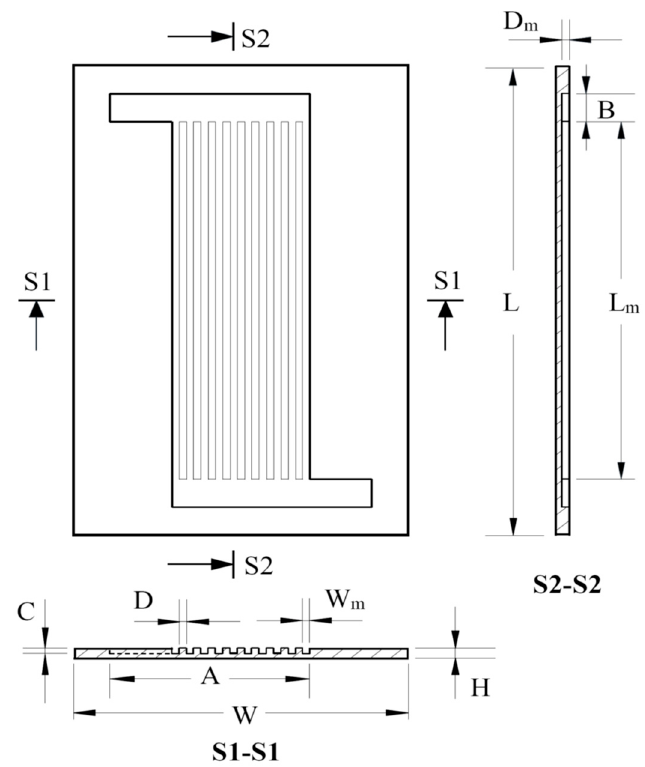
Figure 1. The design of the microchannel condenser. Table 1. The geometric